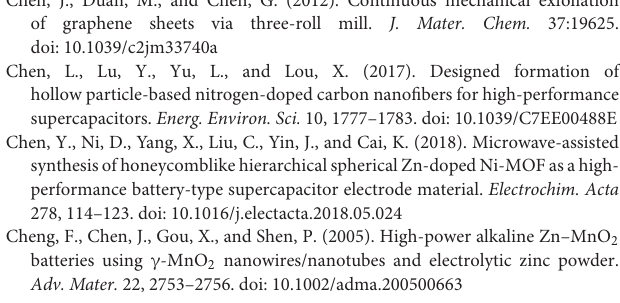
current density of 50 mV s − 1 in Figure 3D . Significantly,